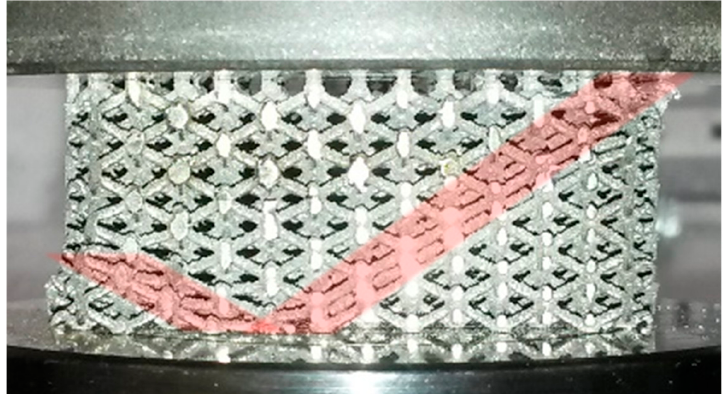
Figure 21. Actual deformation in BCC during compression testing. Areas of diagonal shear collapse have been highlighted faintly in red.